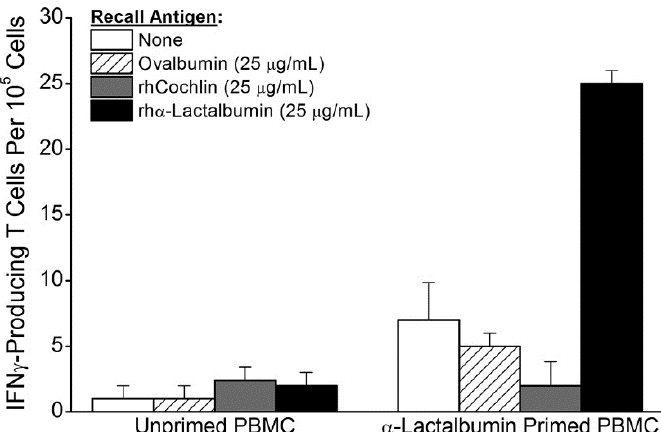
Figure 1. In Vitro Priming of Human peripheral blood mononuclear cells ( PBMC) to rh α -Lactalbumin. Monocyte derived dendritic cells ( DCs) prepared from PBMC taken from a 29 year-old healthy woman were loaded with purified rh α -lactalbumin and used to prime PBMC-derived T cells from the same donor. Recall responses to rh α -lactalbumin and the irrelevant control antigens ovalbumin and rhcochlin showed that 1 out of 20,000 cells were antigen-specific T cells. The observed α -lactalbumin responsiveness is representative of similar results obtained from several different women. Error bars indicate ±SD.